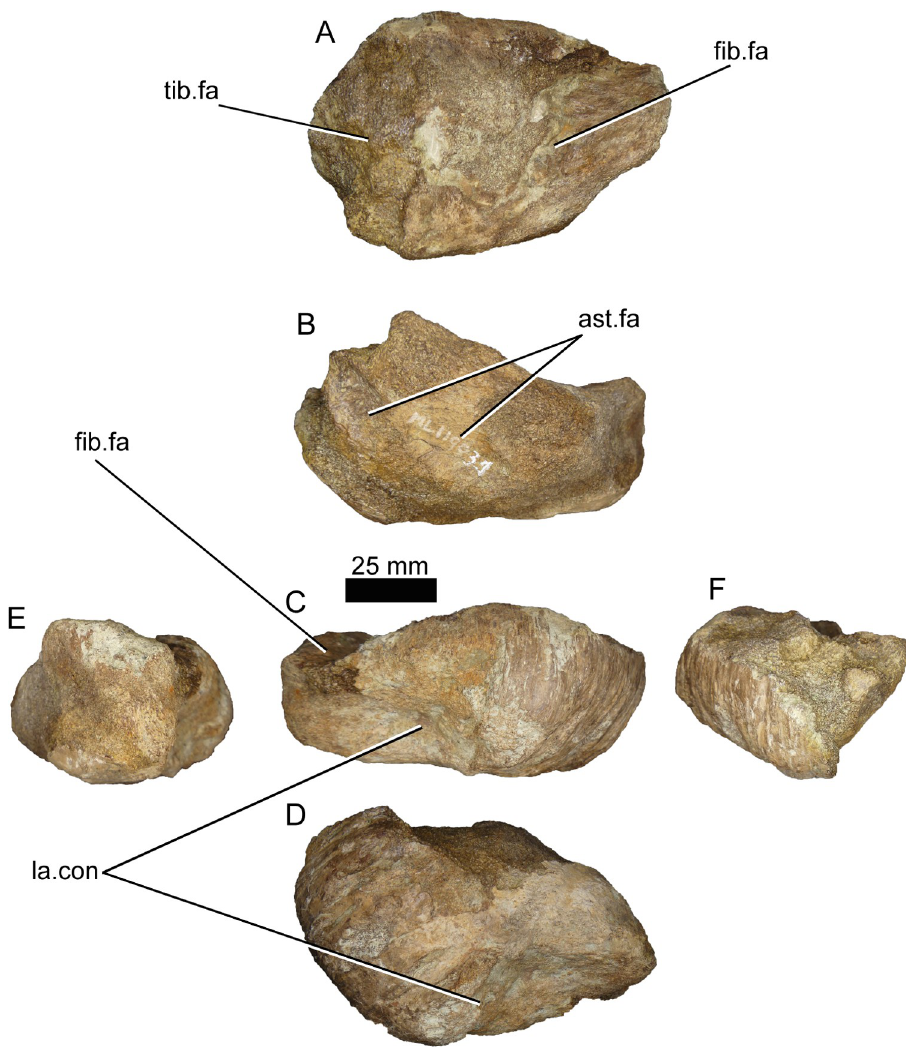
Fig 24. Left calcaneum of Iberospinus natarioi (ML1190-31). A , proximal, B , lateral, C , medial, D , distal, E , anterior and F posterior view. ast.fa , astragalar facet, fib.fa , fibular facet, la.con , lateral concavity, tib.fa , tibial